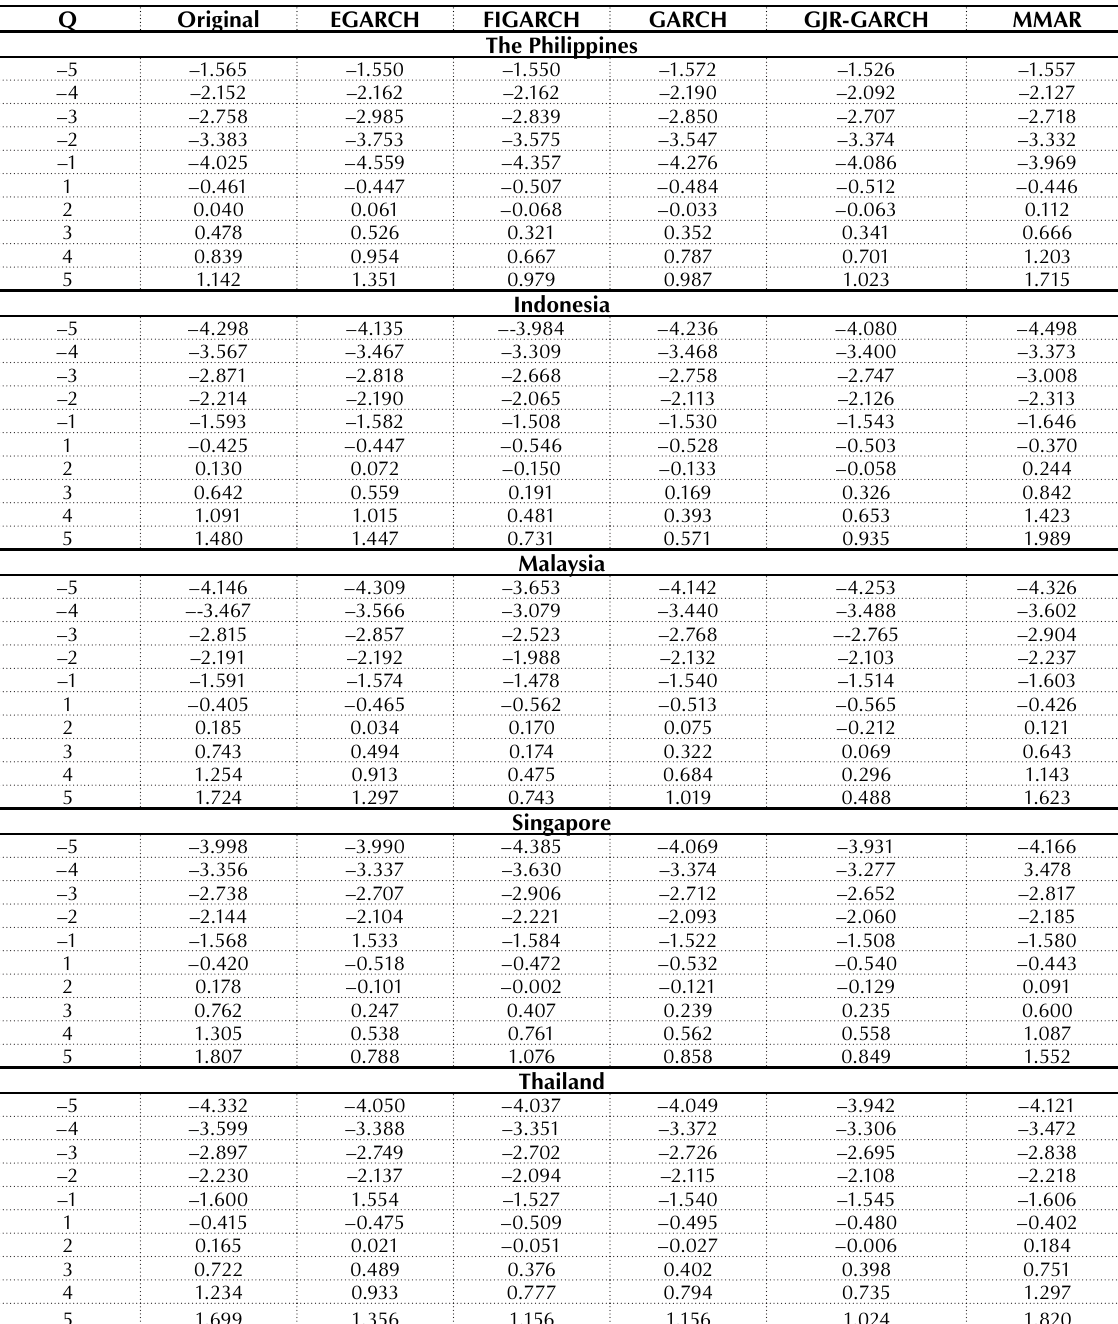
Table 9. Scaling